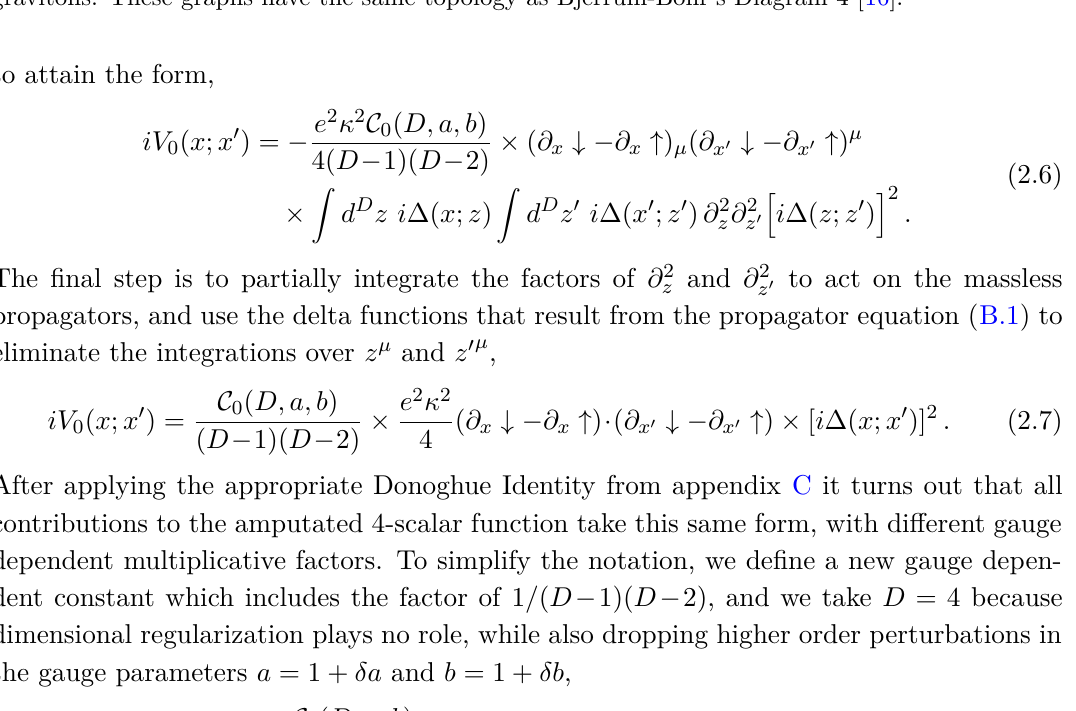
Figure 2 . This diagram shows the contribution of graviton correlation between two vertices. Dashed lines represent massive scalars, wavy lines represent photons and curly lines